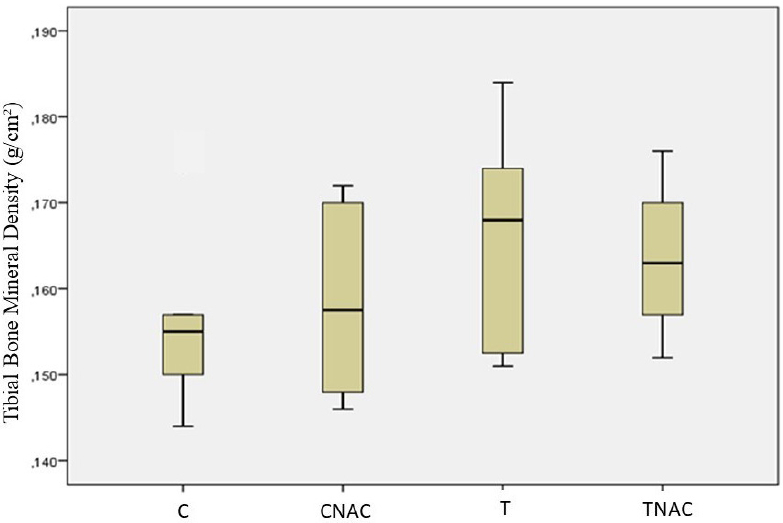
Figure2 :Analysis of tibial bone mineral density in the four groups of animals. C: Control; CNAC: Control with N-acetylcysteine supplementation; T: Concurrent Training; TNAC: Concurrent Training with N-acetylcysteine supplementation. ANOVA Analysis of variance test, with significance of 5% (p>